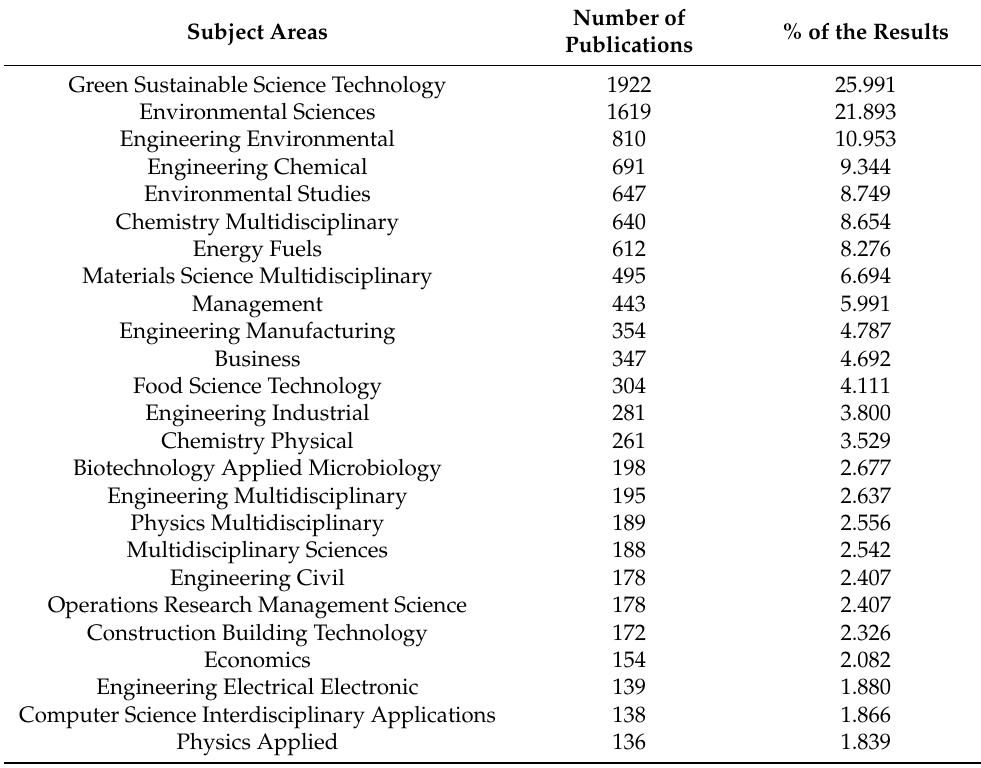
Table 1. Summary of the WoS search results using “sustainable product design” and their subject